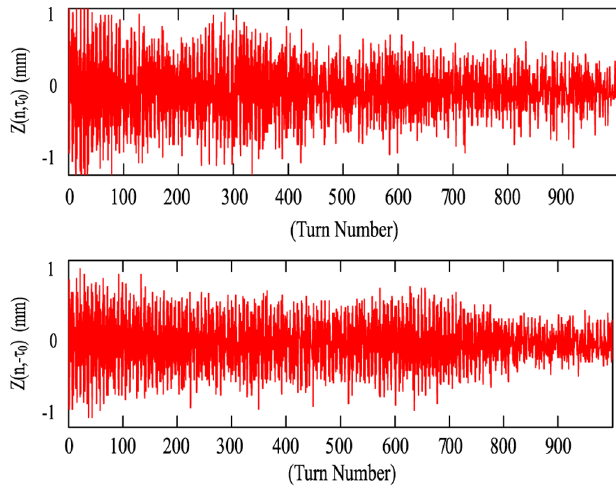
FIG. 6. (Color) Plot of Z (cid:3) n; (cid:1) (cid:4) measured versus n turns. Shown (cid:5) 0 : 9 (cid:10) 10 11 . The transverse is a low intensity bunch with N p beam motion after 1 mm kick with 0.4 nsec longitudinal bunch (cid:5) slices of head (top) and the tail (bottom) each 4 nsecs ( (cid:1) 0 4 nsecs ) from the bucket center. Chromaticity measured to be (cid:5) 3 nsecs . (cid:4) (cid:5) 4 : 0 (cid:9) 1 and (cid:8) (cid:1)